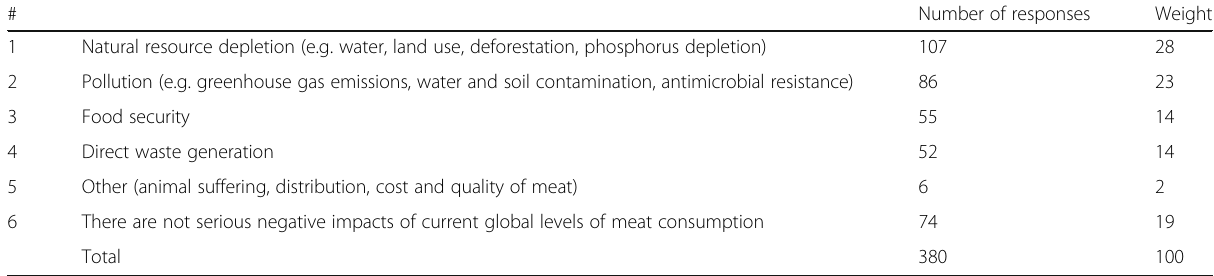
Table 8 Most serious negative impacts of current global levels of meat consumption: 2018 Sydney responses (multiple answers allowed)